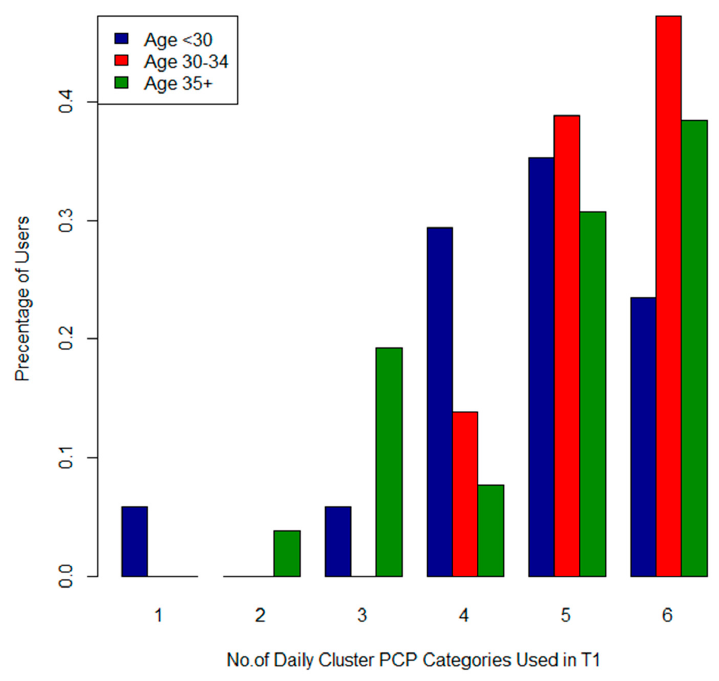
Figure 10. Total number of Cluster 1 (Luxury) PCPs used by income for T1. Int. J. Environ. Res. Public Health 2016 , 13 , 105